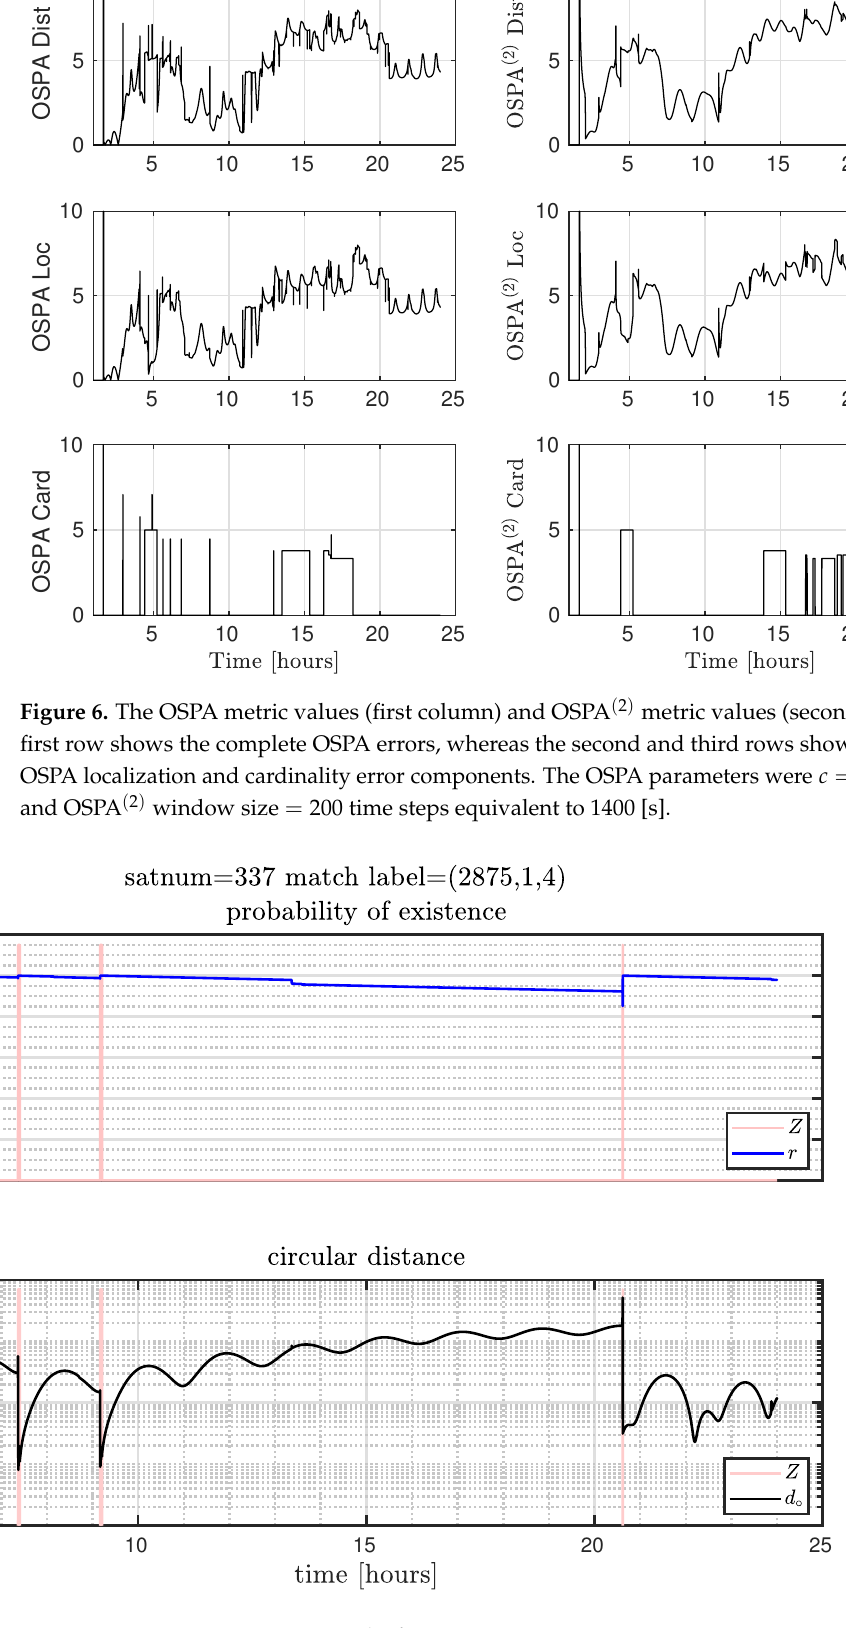
Figure 7. Trajectory results for satnum =